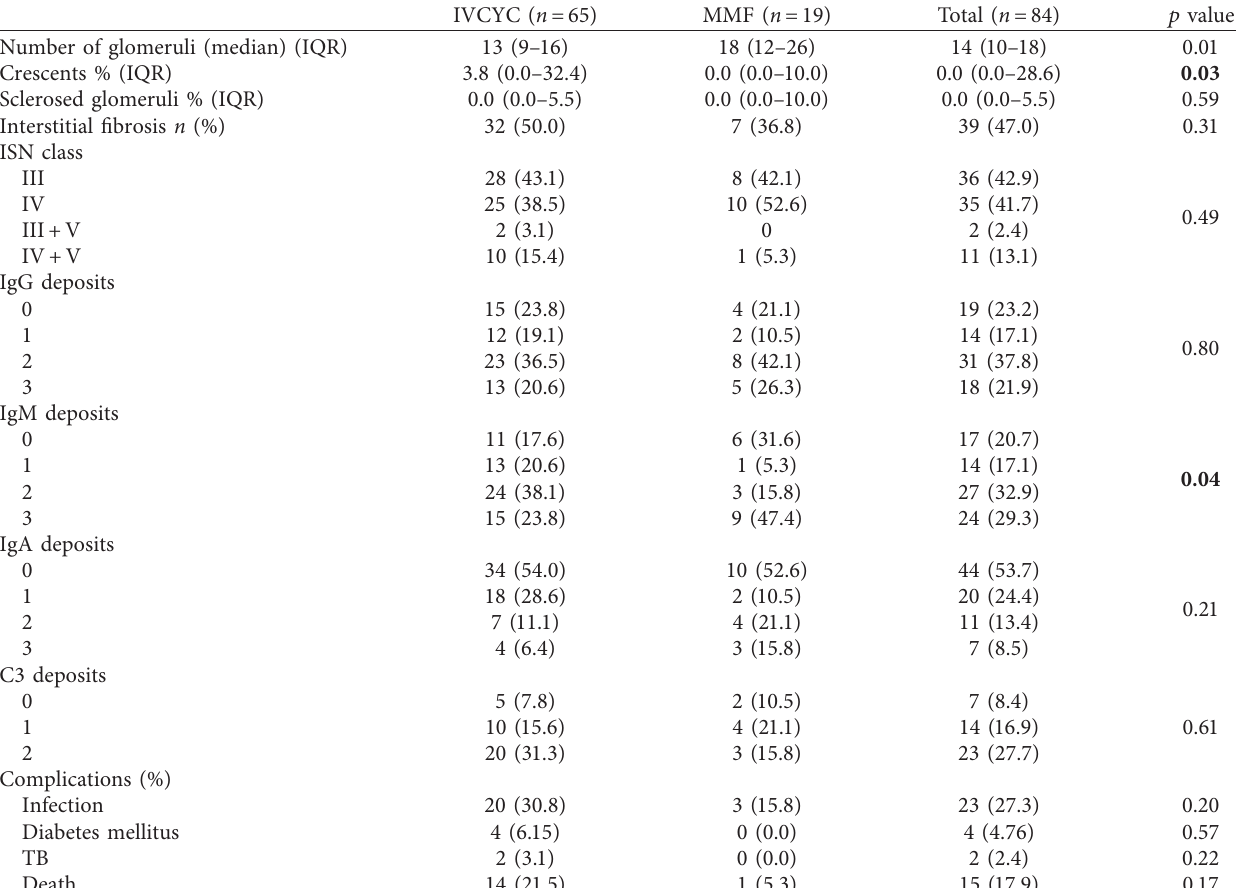
Table 2: Histopathological data and complications associated with both treatment groups.